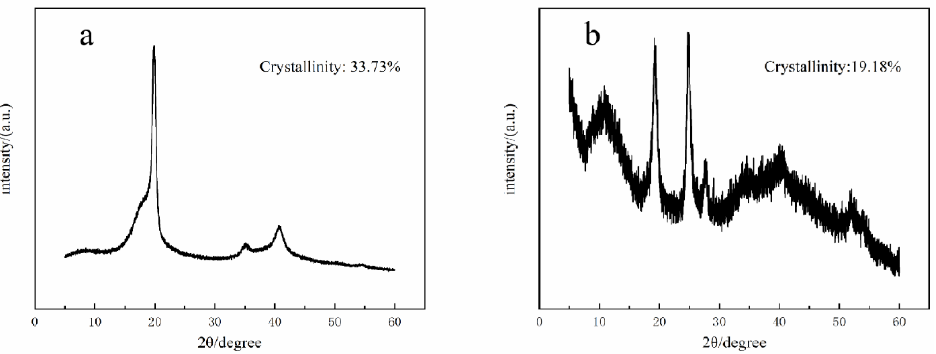
Figure 4. ( a ) XRD image of non-modified PVDF powder ( b ) XRD image of fiber membrane of the PVDF fiber fabricated together with AuNPs.